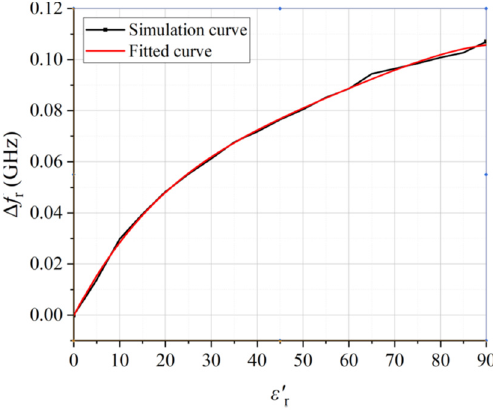
(cid:48) ∆ f ε′ Δ r . and r f . Figure 9. The relationship between ε r and